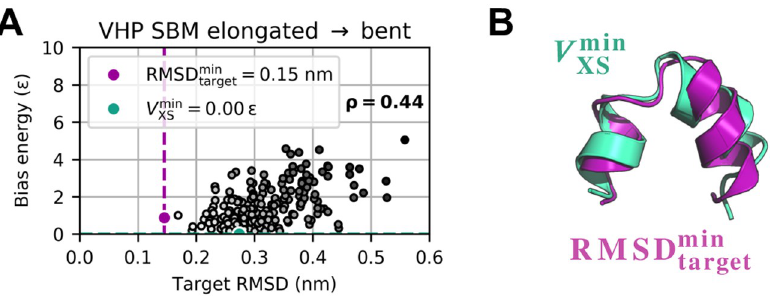
Fig 4. Bias potential versus target RMSD for elongated-to-bent transition. (A) Bias potential versus target RMSD. (B) RMSD min (purple) and V min (turquoise) structure have a C α RMSD of 0.25 nm with respect to each target XS